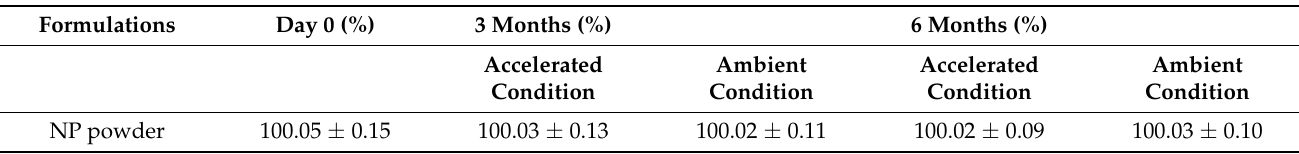
Figure 6 Percent cellular absorption of 5RH4/16, 5RH8/32, and 7RH8/32 NP powders after 3 hours of exposure to each formulation. (n = 3) ( * p < 0.05).